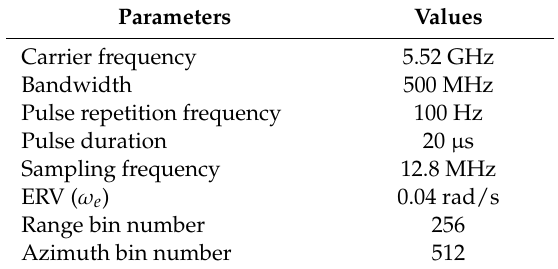
Table 2. Main Simulated Parameters. ERV: e ff ective rotational velocity.